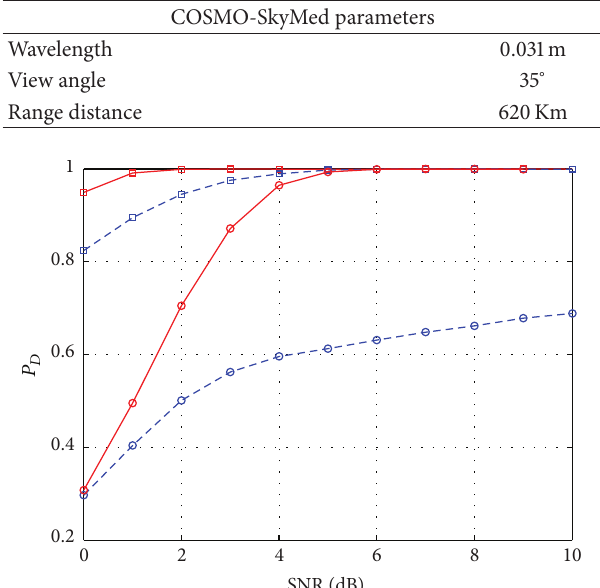
Figure 2: 𝑃 𝐷 versus SNR for SequOMP detector (blue dashed line) and Sup-GLRT detector (red solid line), in the case of two scatterers of same amplitude and at a distance 𝐷 𝑠 = 2𝜌 𝑠 , with 𝑃 13 (circle markers), and 𝑀 = 25 (square